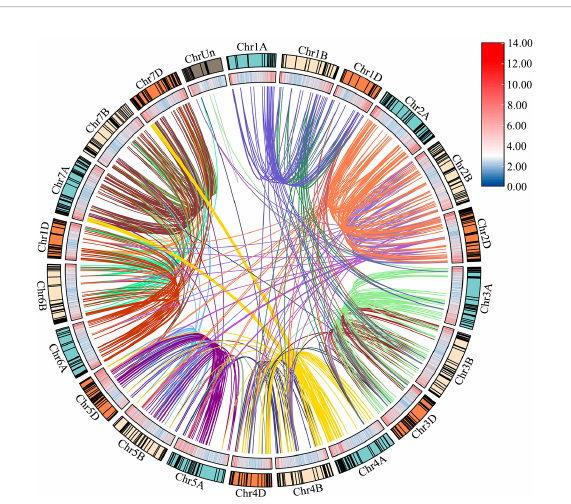
FIGURE 2 Chromosome distribution and duplication of the wheat LRR- RLK genes. Outer circle with colored blocks illustrates different chromosomes, and the short black lines indicate the location of these genes on chromosomes. The wheat gene density is displayed by heat map on the inner circle, and collinearity events are marked with different colored lines in center. The graphs of chromosomal location and synteny analysis were established using TBtools.